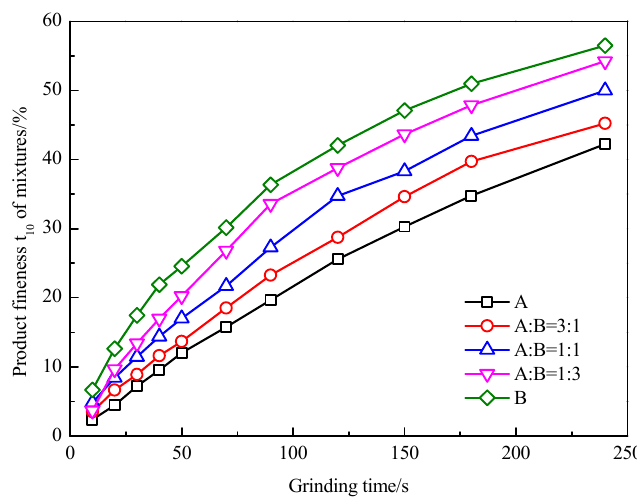
Figure 4. Product fineness t 10 of mixtures for various grinding times. Table 1. Sulfur content of − 0.25 mm products yielded at various grinding times.